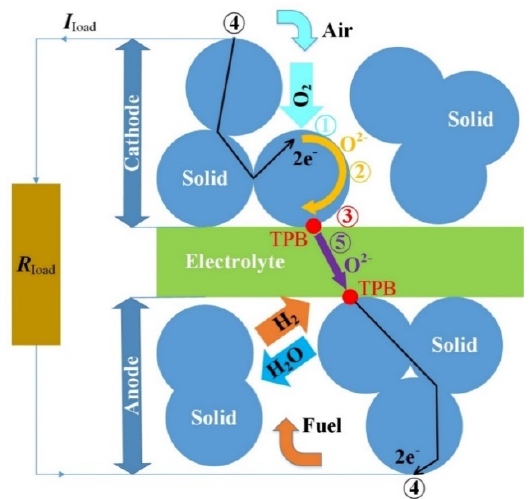
Figure 2. Illustrated charge transfer within the solid oxide fuel cell (SOFC).